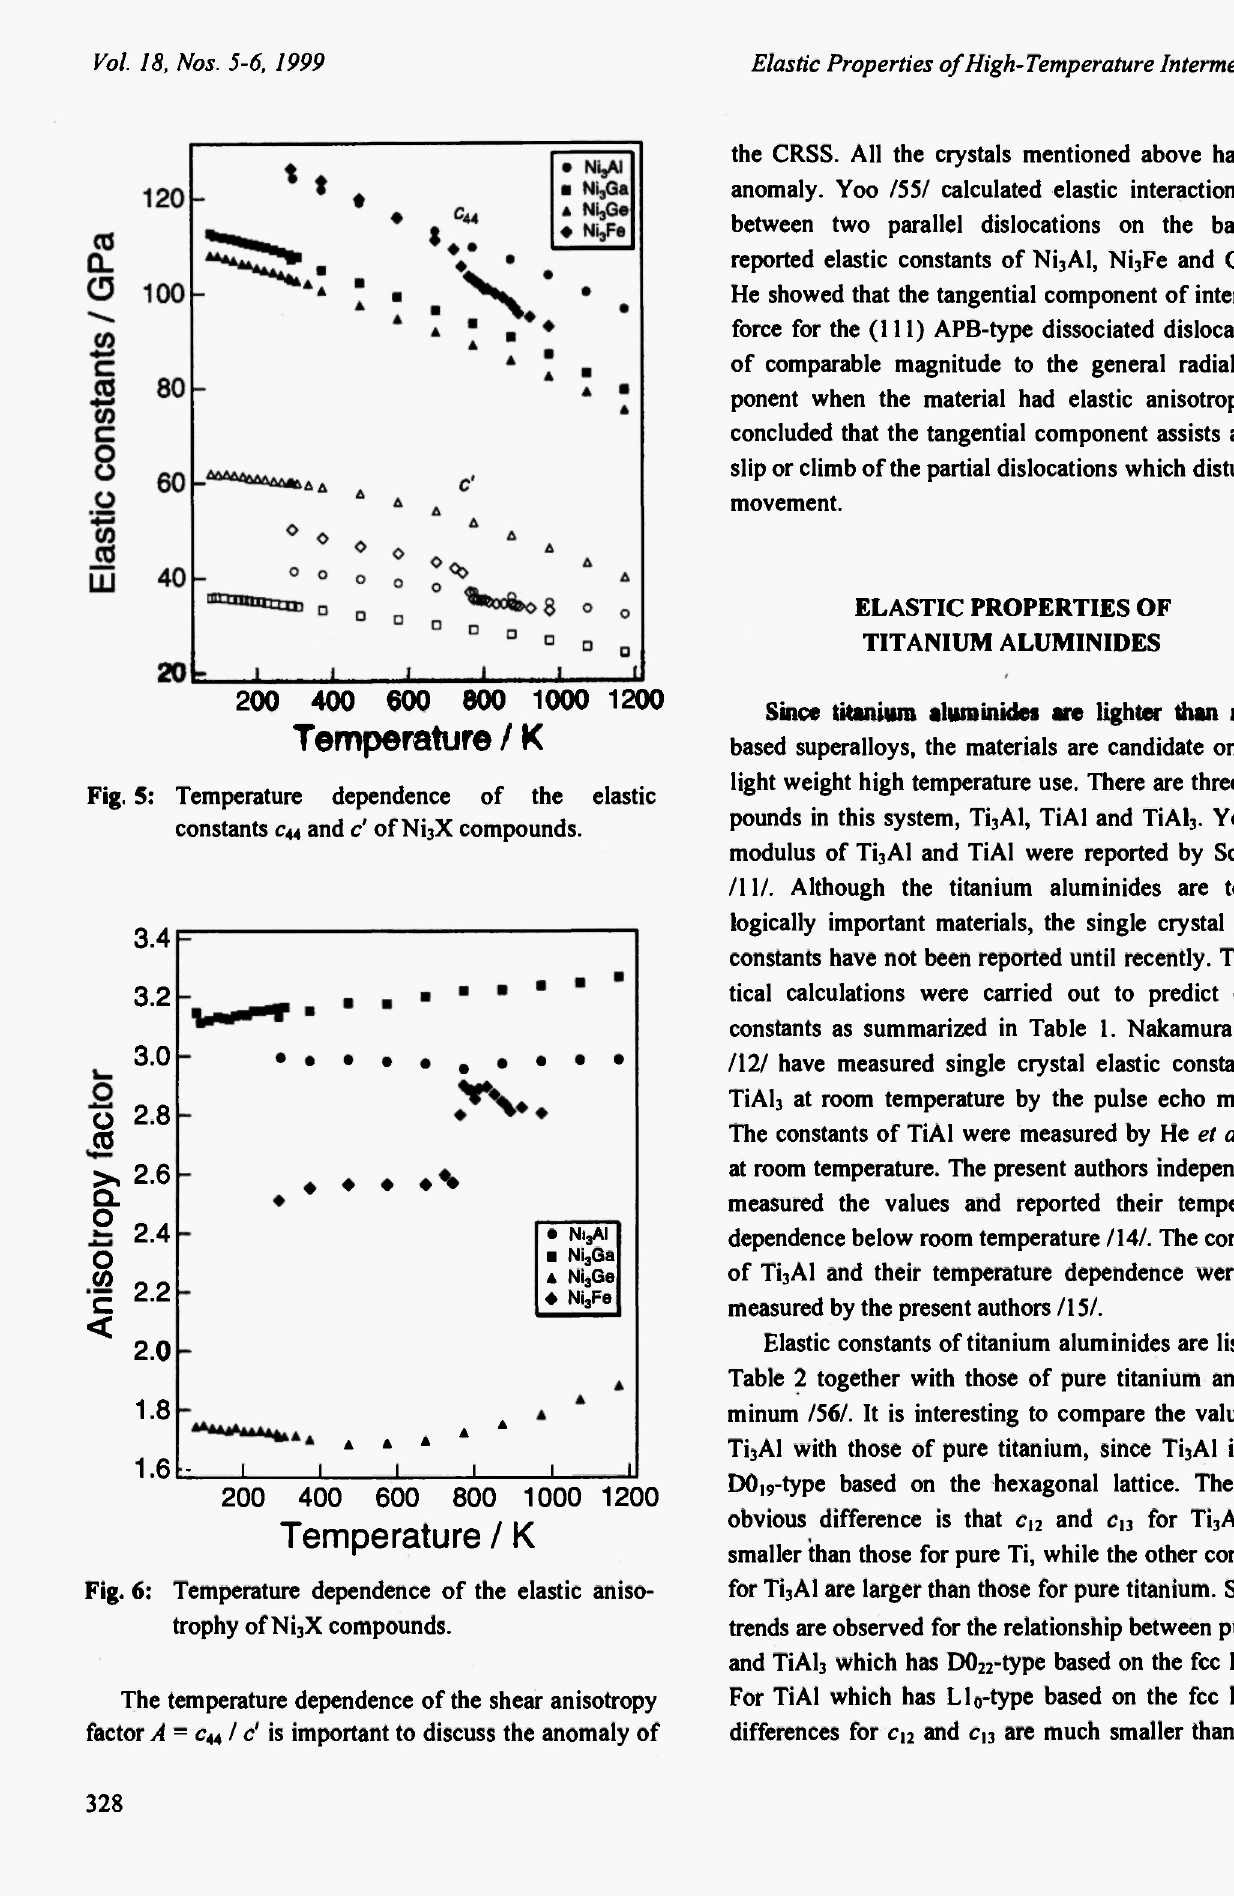
Fig. 6: Temperature dependence of the elastic aniso- trophy of Ni X compounds. 3 The temperature dependence of the shear anisotropy factor A = c / d is important to discuss the anomaly 44